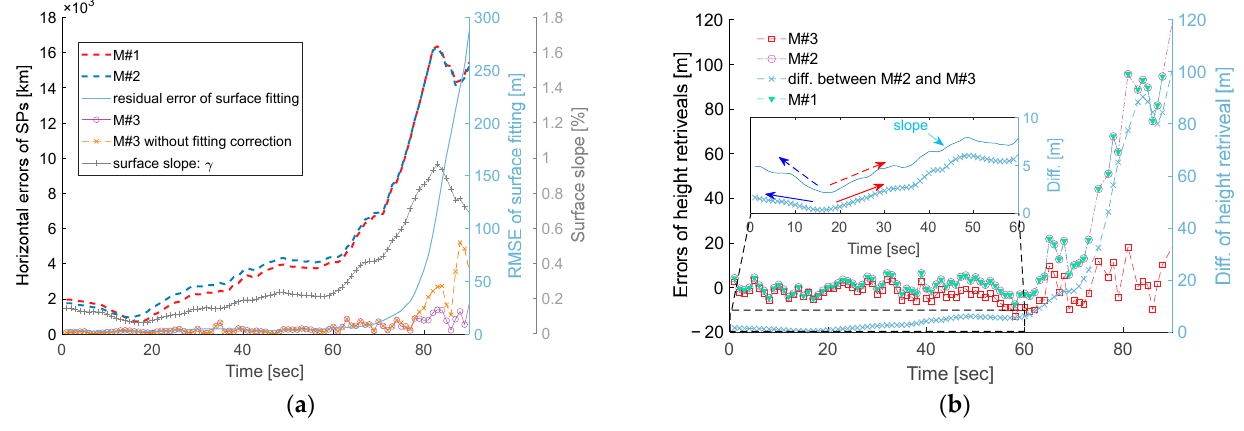
Figure 8. Comparisons of the results in horizontal ( a ) and vertical ( b ) directions obtained from the three methods.